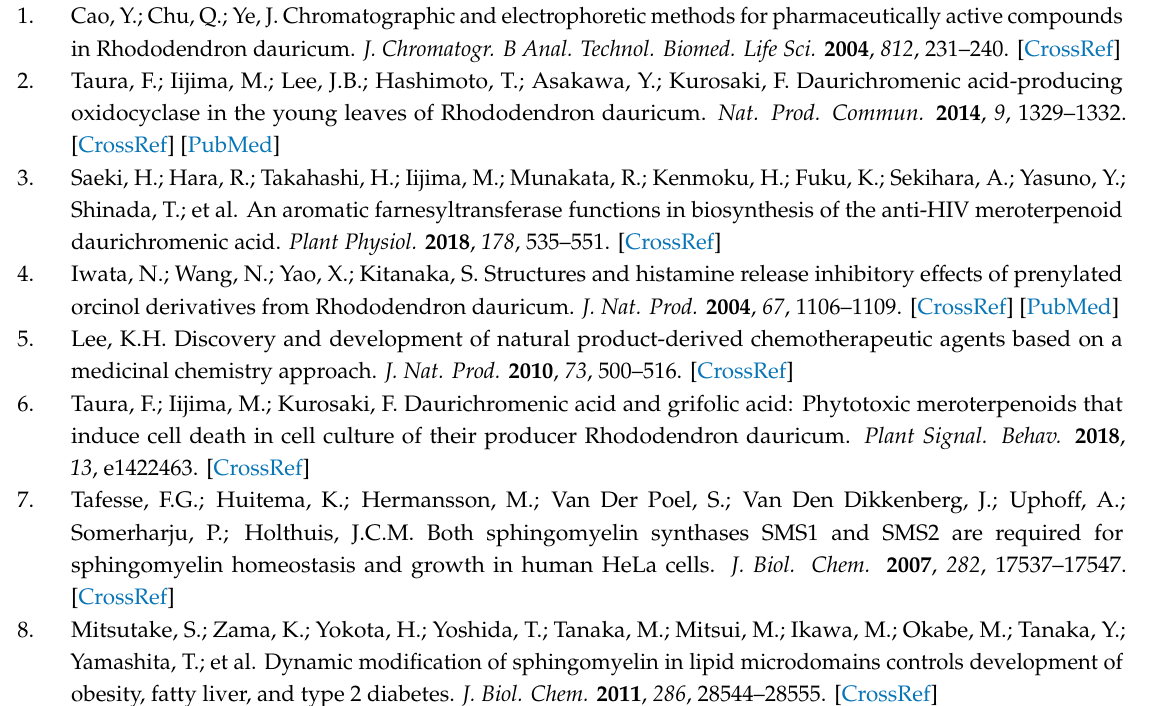
Supplementary Materials: The following are available online. Figure S1: NMR spectra of daurichromenic acid and its derivatives, Figure S2: A β aggregation inhibition activity of DCA and its